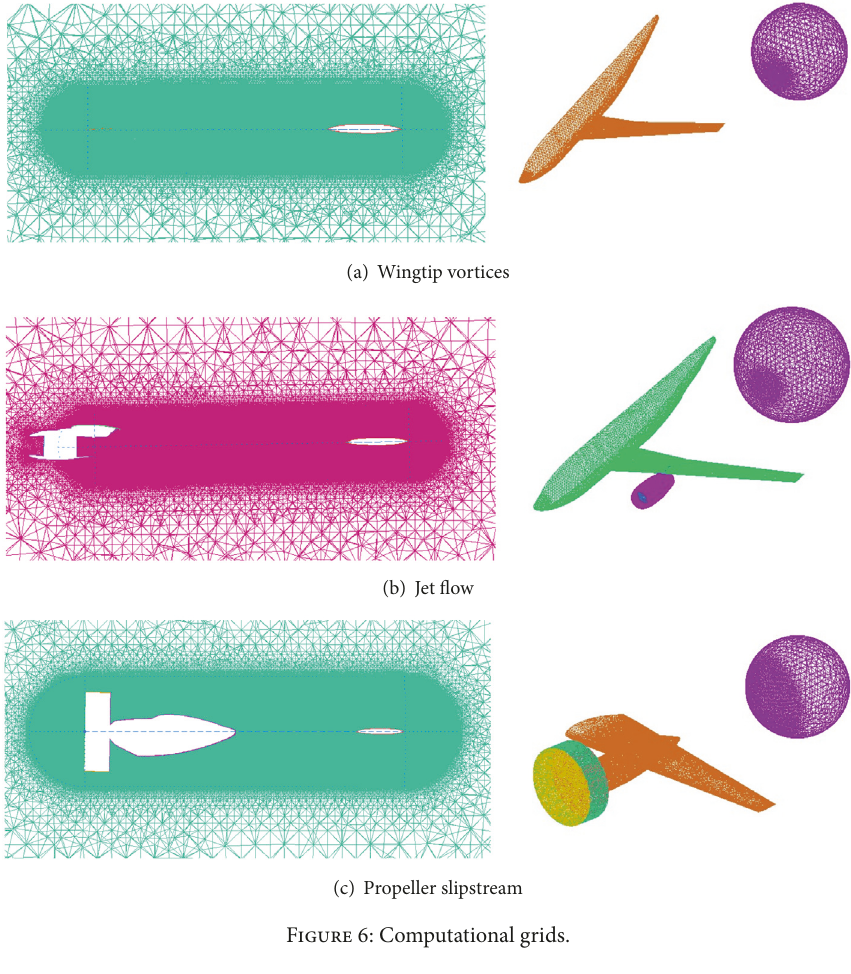
Figure 6: Computational grids.